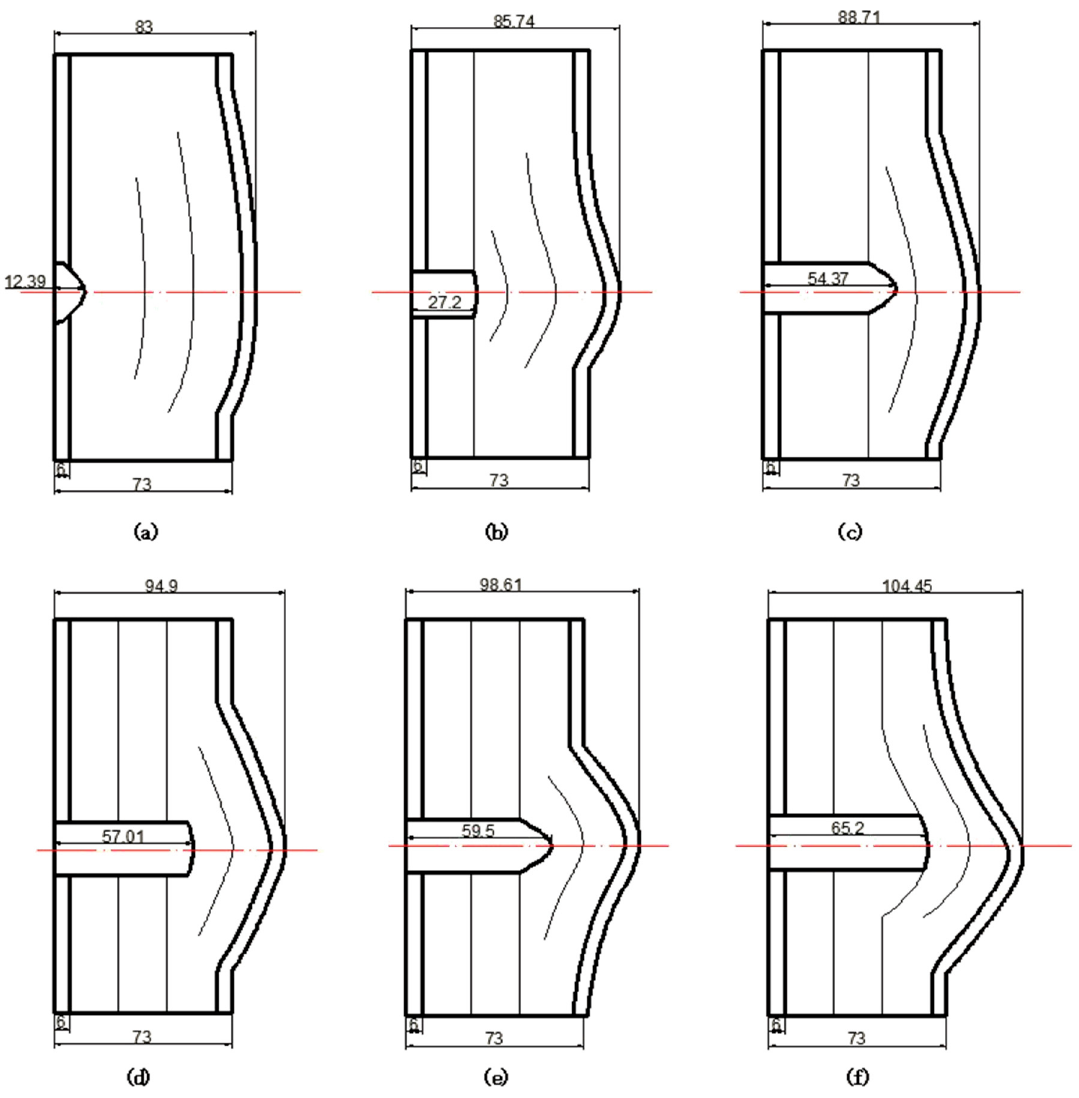
Figure 11. Deformation and perforation profiles of armor with three layers of PE (unit: mm). ( a ) v = 683 m/s. ( b ) v = 778 m/s. ( c ) v = 1175 m/s. ( d ) v = 1190 m/s. ( e ) v = 1127 m/s. ( f ) v = 1304 m/s.